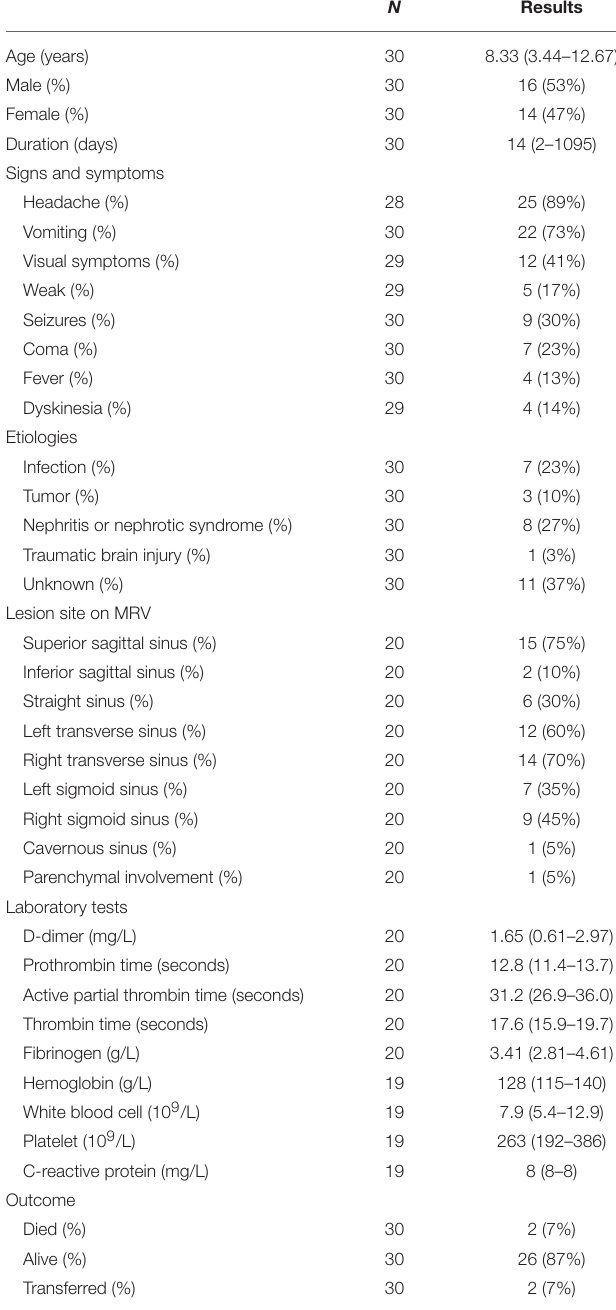
TABLE 1 | Characteristics of the